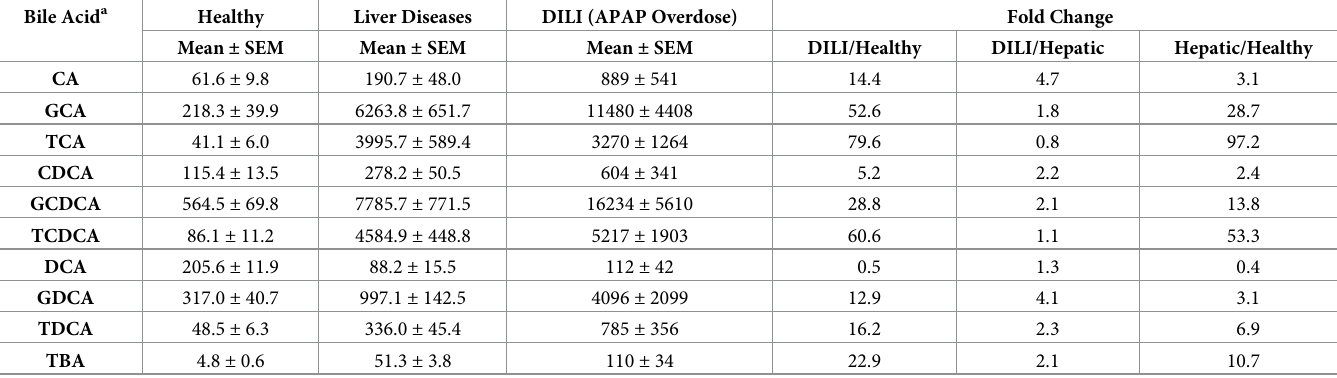
APAP, acetaminophen; BA, bile acid; CA, cholic acid; CDCA, chenodoxycholic acid; DCA, deoxycholic acid; DILI, drug-induced liver injury; TCA, taurocholic acid; GCA, glycocholic acid; GCDCA, glycochenodeoxycholic acid; SEM, standard error of the mean; TCDCA, taurochenodeoxycholic acid; TDCA, tauodeoxycholic acid. a TBA unit is in umol/L; all other units are